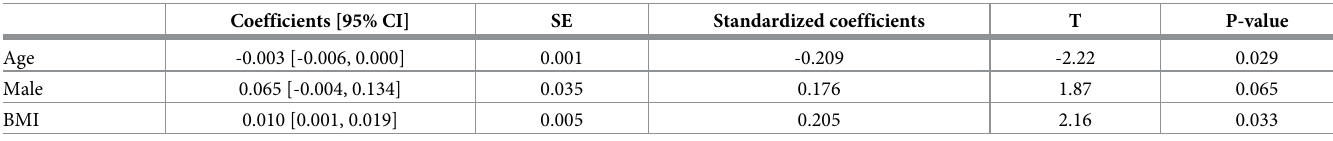
Table 2. Multiple regression analysis (30 min after the surgical